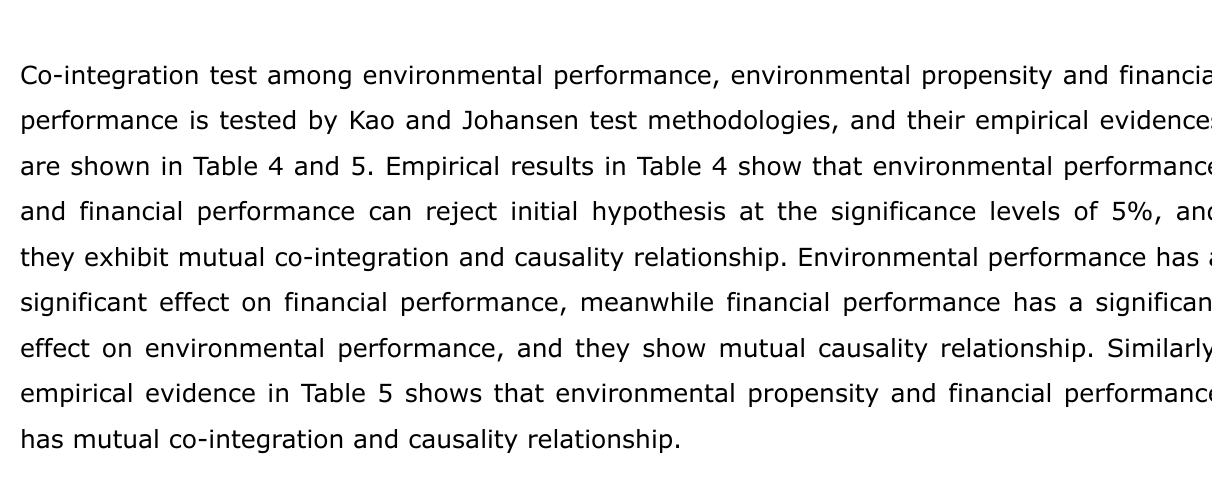
Table 5. Cointegration estimation of panel data between environmental propensity and financial